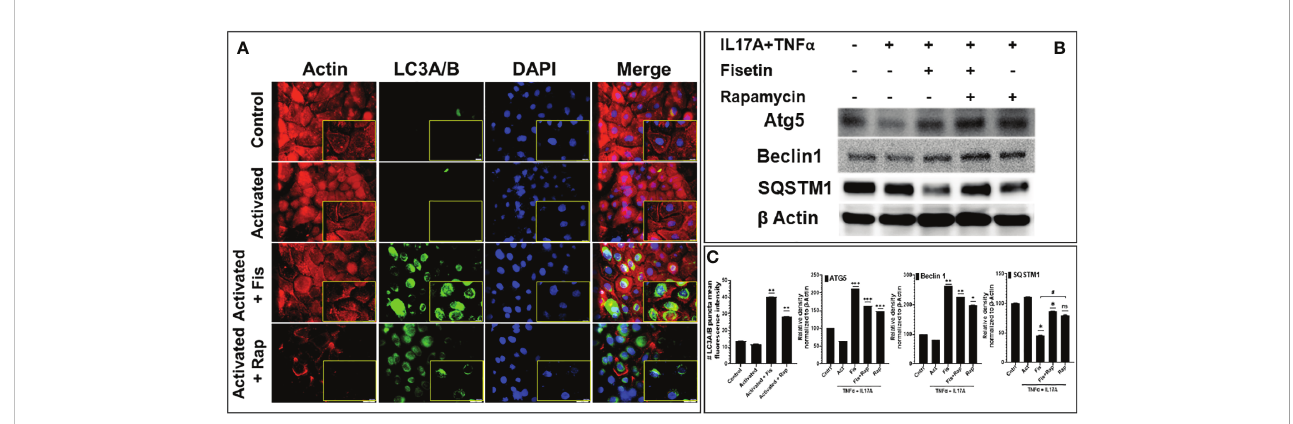
FIGURE 3 Fisetin induces the expression of autophagy markers in cytokine-stimulated primary epidermal keratinocytes. (A) Representative photographs of the immuno fl uorescence staining for actin (red) and LC3A/B (green) and the DAPI staining (blue; for nucleus) in fi setin (15 µM), rapamycin (100 nM) or IL-17A +TNFa)-treated HEKa compared with inactivated control keratinocytes/HEKa. (B) Western blot analysis for differential protein levels of autophagy markers Atg5, Beclin1 and SQSTM1 in fi setin- or rapamycin-treated primary keratinocytes activated with cytokines (IL-17A+TNF a ) in vitro . (C) Semi-quanti fi cation of the bands for LC3A/B, Atg5, and Beclin1 and SQSTM1. Bar is means ± SD of three separate experiments. *P <0.05, **P < 0.01, and ***P < 0.001 vs. control for activated (IL-17A+TNF a ) only and activated with keratinocytes treated with fi setin or rapamycin. When contrasting the treatment groups for